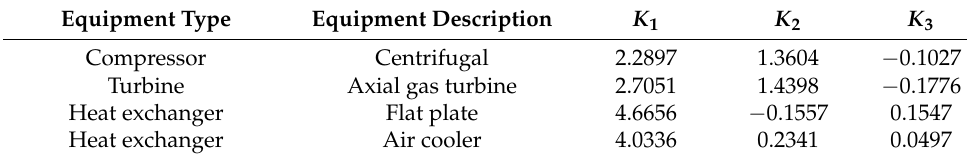
Table 5. Equipment purchase cost constants